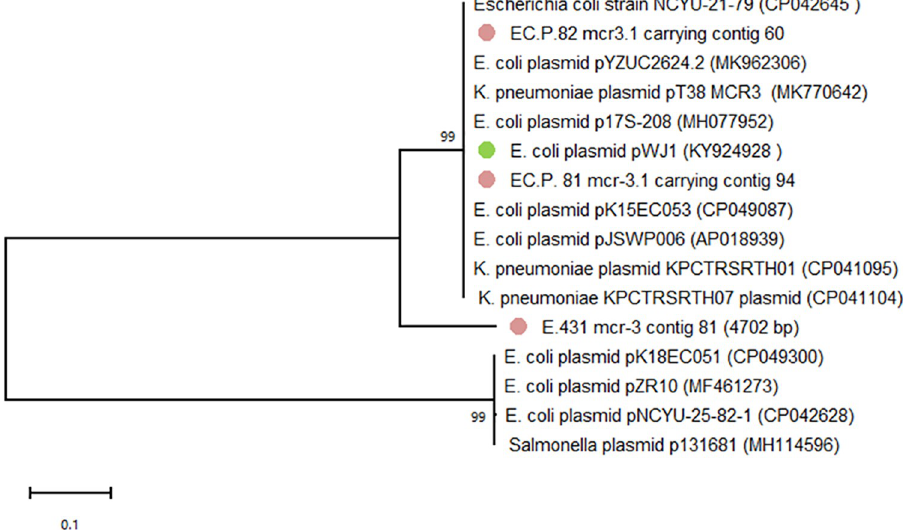
Fig 4. Phylogenetic tree of core genome sequences in E.431, ECP.81 and ECP.82 and other mcr-3 plasmids deposited in the GenBank database. Sequences were aligned using MUSCLE and phylogenetic interferences were obtained using the maximum likelihood method within the MEGA 10 software. Numbers at the nodes are percentages of bootstrap values obtained by repeating the analysis of 1000 times to generate a majority of consensus tree.